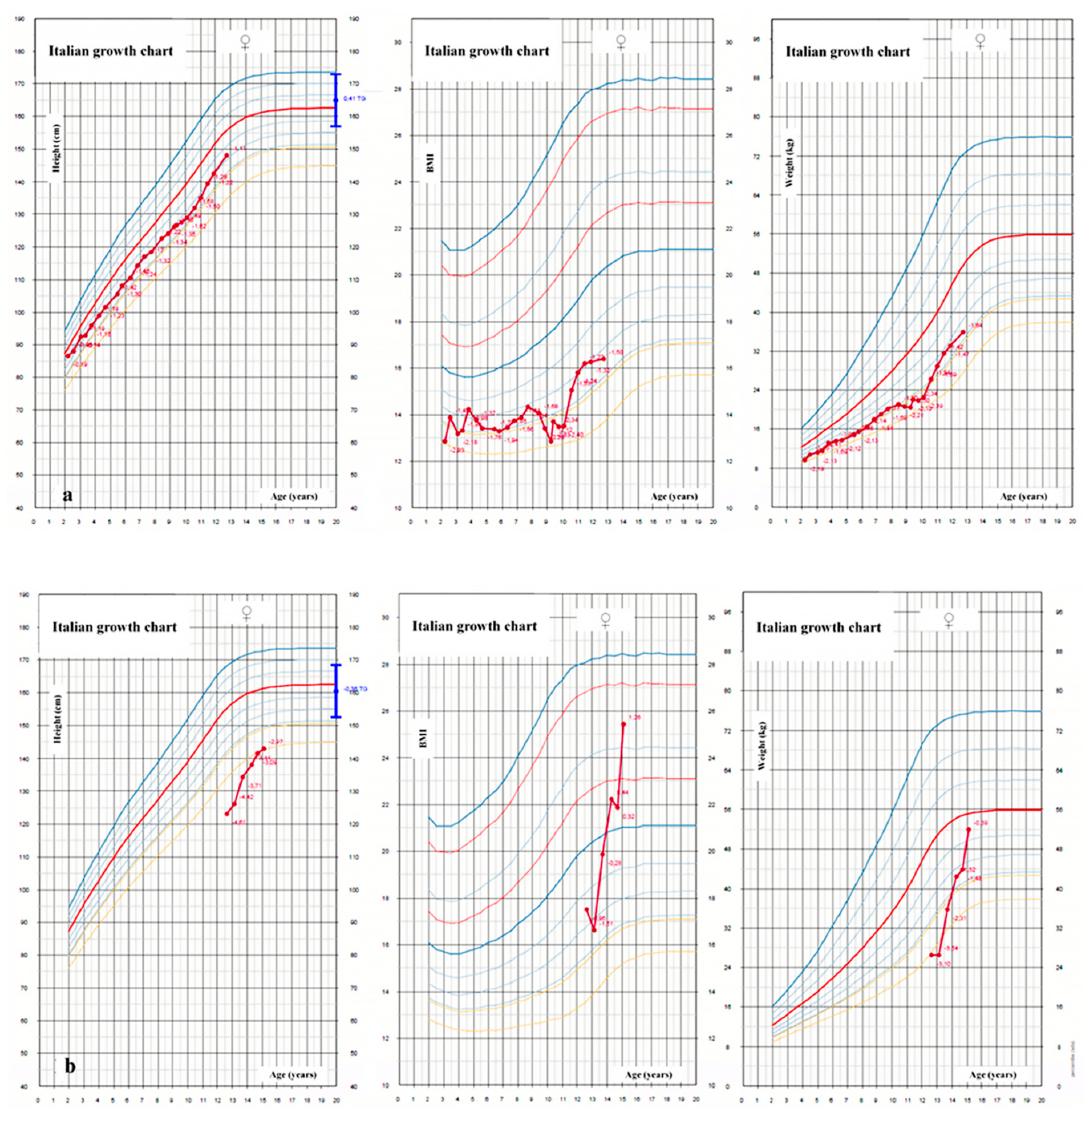
Figure 1. Height, weight and body-mass index (BMI) growth charts of two girls with cystic fibrosis between the ages of 2 and 18 years: a girl with pancreatic insufficiency with good compensation and normal puberty ( a ) and a girl with severe short stature and pubertal delay and pancreatic insufficiency undiagnosed until 12 years of age ( b ).